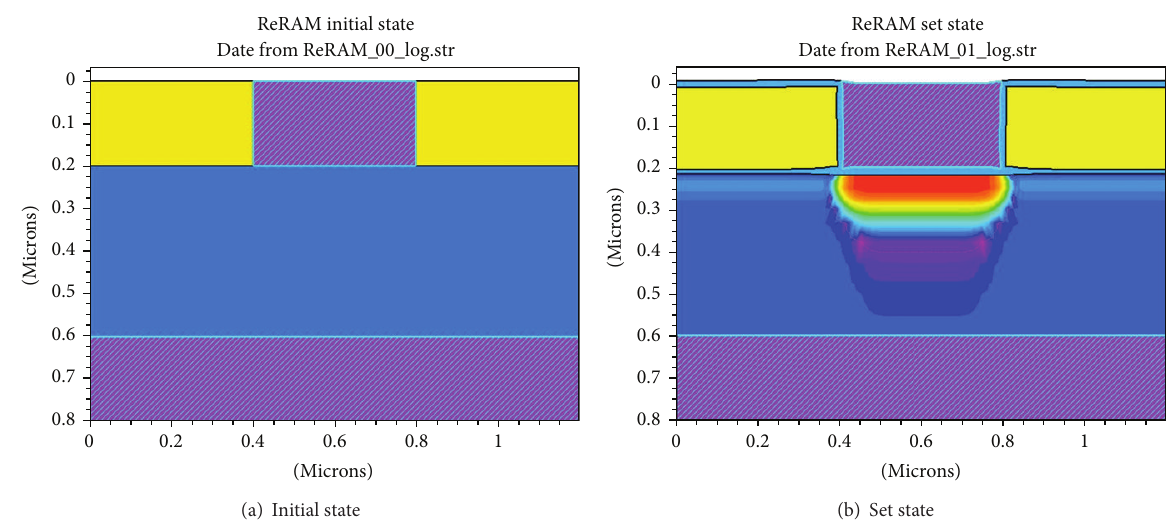
Figure 2: Ion mobility and conduction formation process of the ReRAM device. (a) Initial state, data from ReRAM 00 log.str. (b) Set state, data from ReRAM 01 log.str. The conduction path is formed by applying a lower and longer pulse to obtain a low resistance.